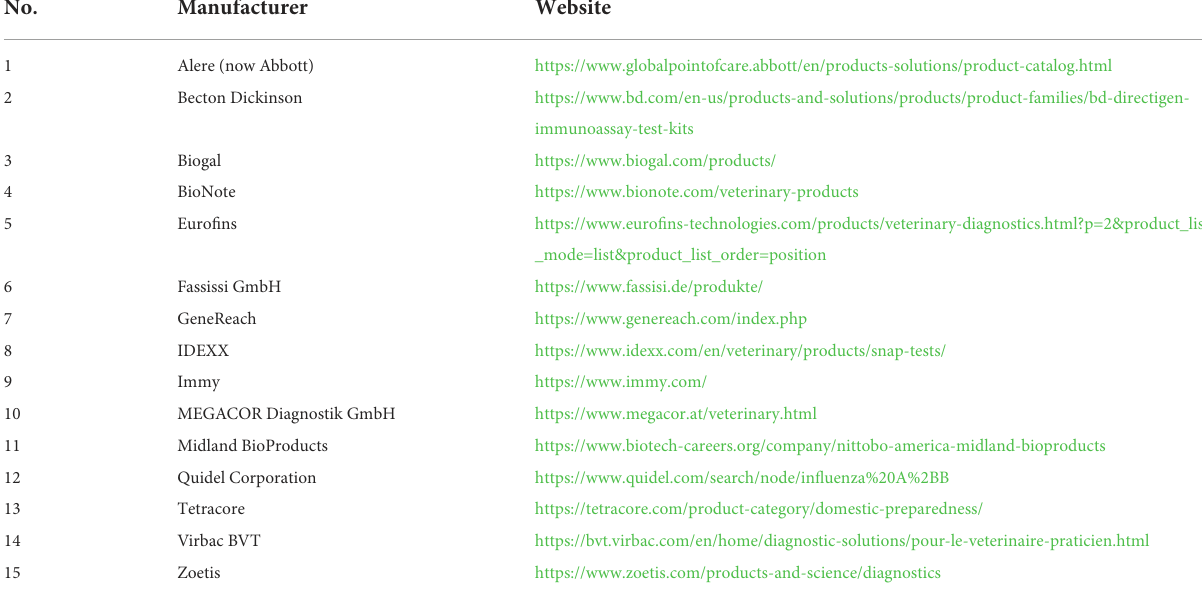
TABLE 3 List of manufacturers’ of POCT assays for infectious diseases in companion and food animals * .